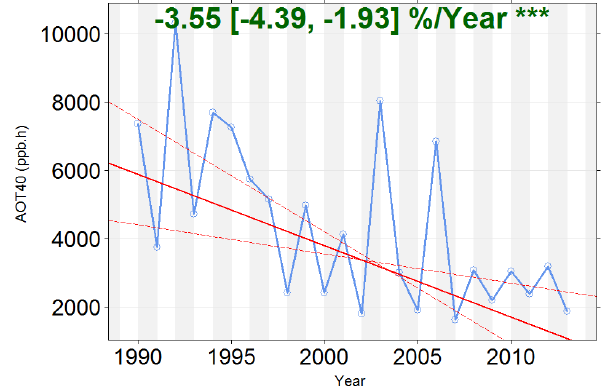
Figure 14. Crop-relevant AOT40 (calculated between May and July) at Harwell for the period 1990–2013. The Theil–Sen trend es- timate of median trend (shown in red) is − 3 . 6%y − 1 ( p = 0 .